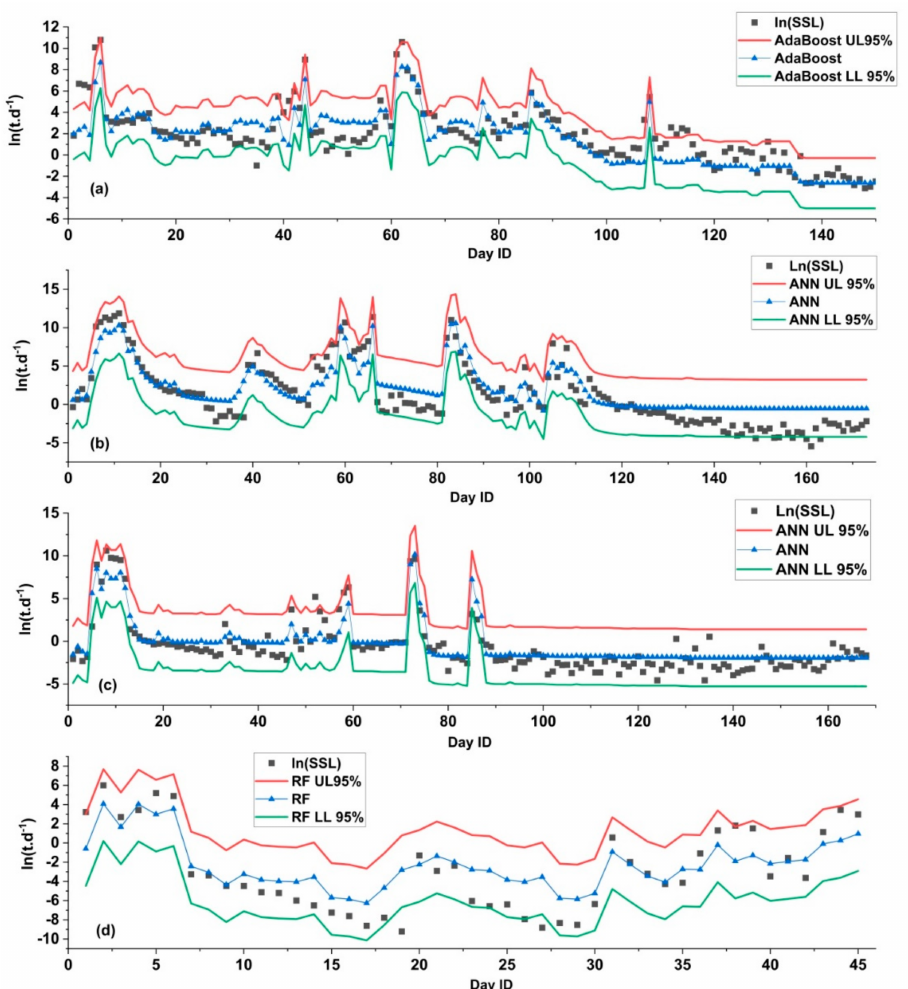
Figure 6. Superimposed plots of the measured and simulated ln(SSL) with 95% upper and lower limits using the best fitted ML models, namely: ( a ) adaptive boosting (Adaboost) model for simulating the SSL in Aguibat Ziar; ( b ) artificial neural network (ANN) model for simulating the SSL in Ras Fathia station; ( c ) artificial neural network (ANN) model for simulating the SSL in SM Cherif station; ( d ) random forest (RF) model for simulating the SSL in Ain Loudah